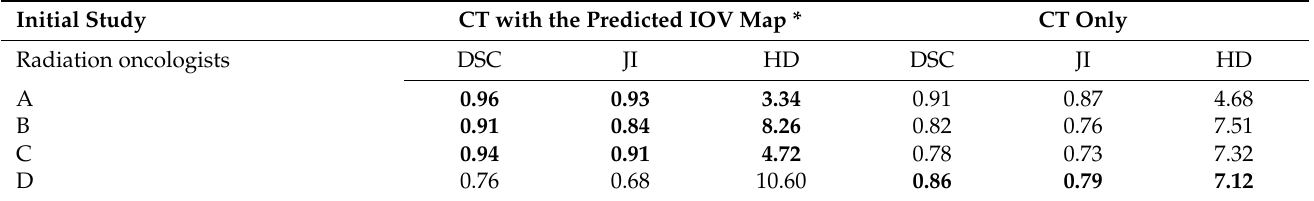
Table 1. Comparison results of the Dice similarity coefficient, Jaccard index, and Hausdorff distance of the initial and repeated studies for the test